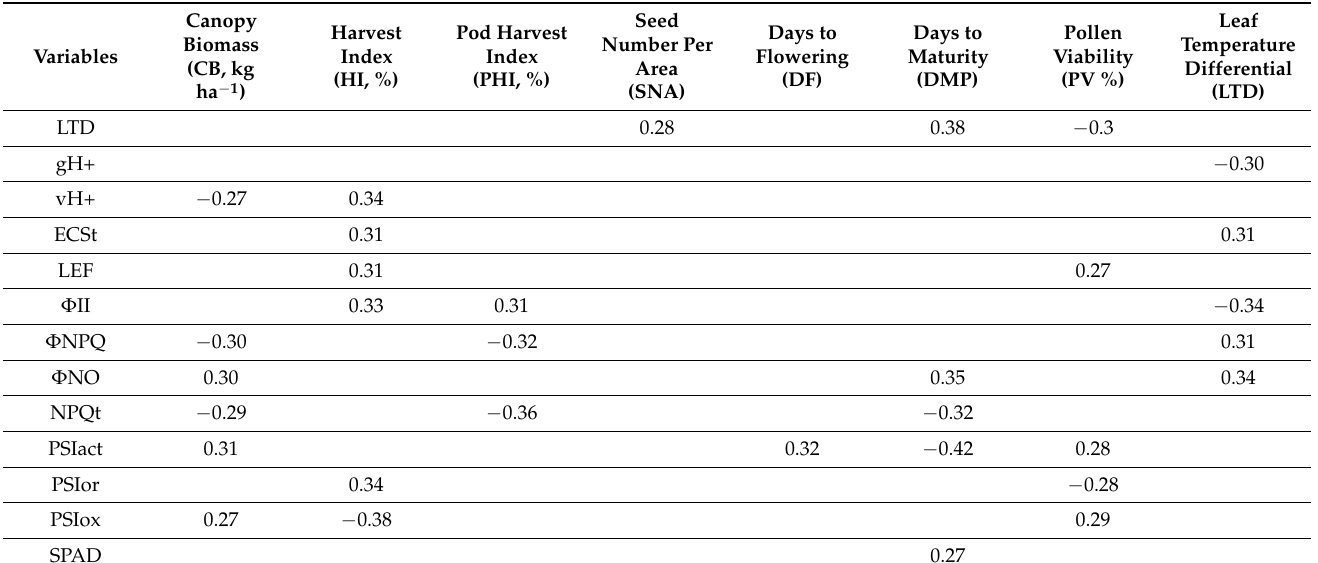
Table 2. Correlation coefficients ( p < 0.05) between different variables related to photosynthetic apparatus functioning and dry matter partitioning indices, phenology and leaf temperature differential of 41 bean genotypes grown under acid soil and high temperature